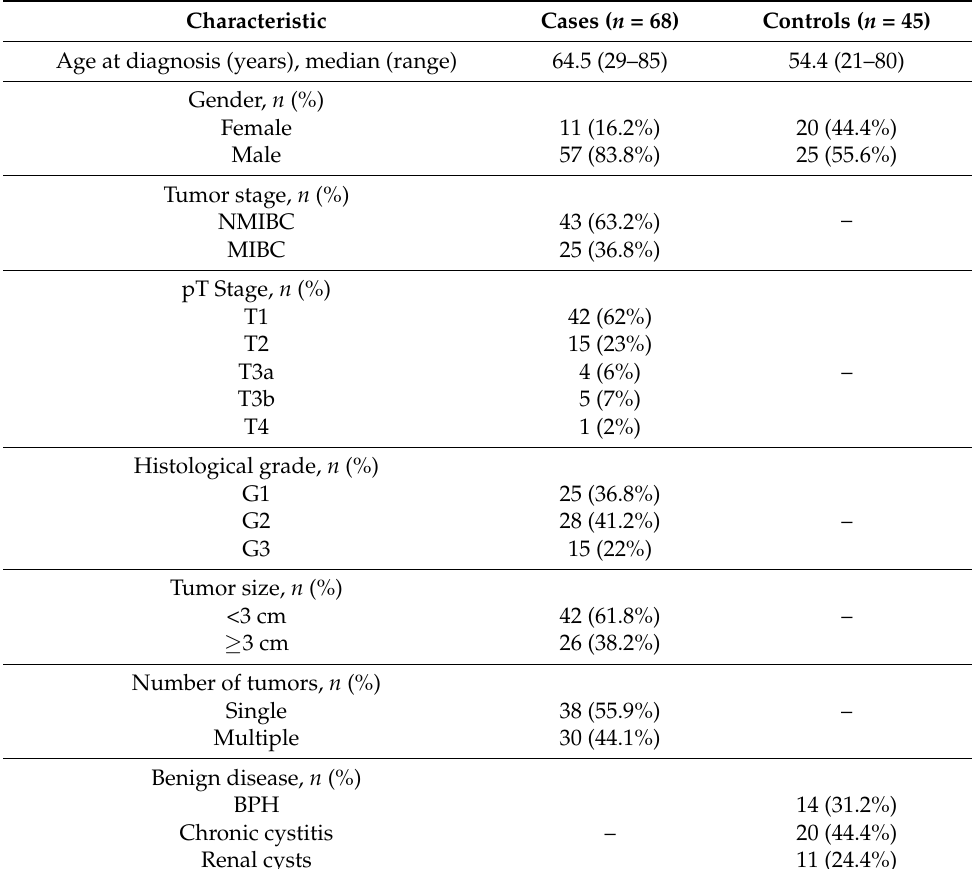
Table 1. Clinicopathologic characteristics of 68 patients with bladder cancer (cases) and 45 controls as well as its association with TA levels in urine and tissue